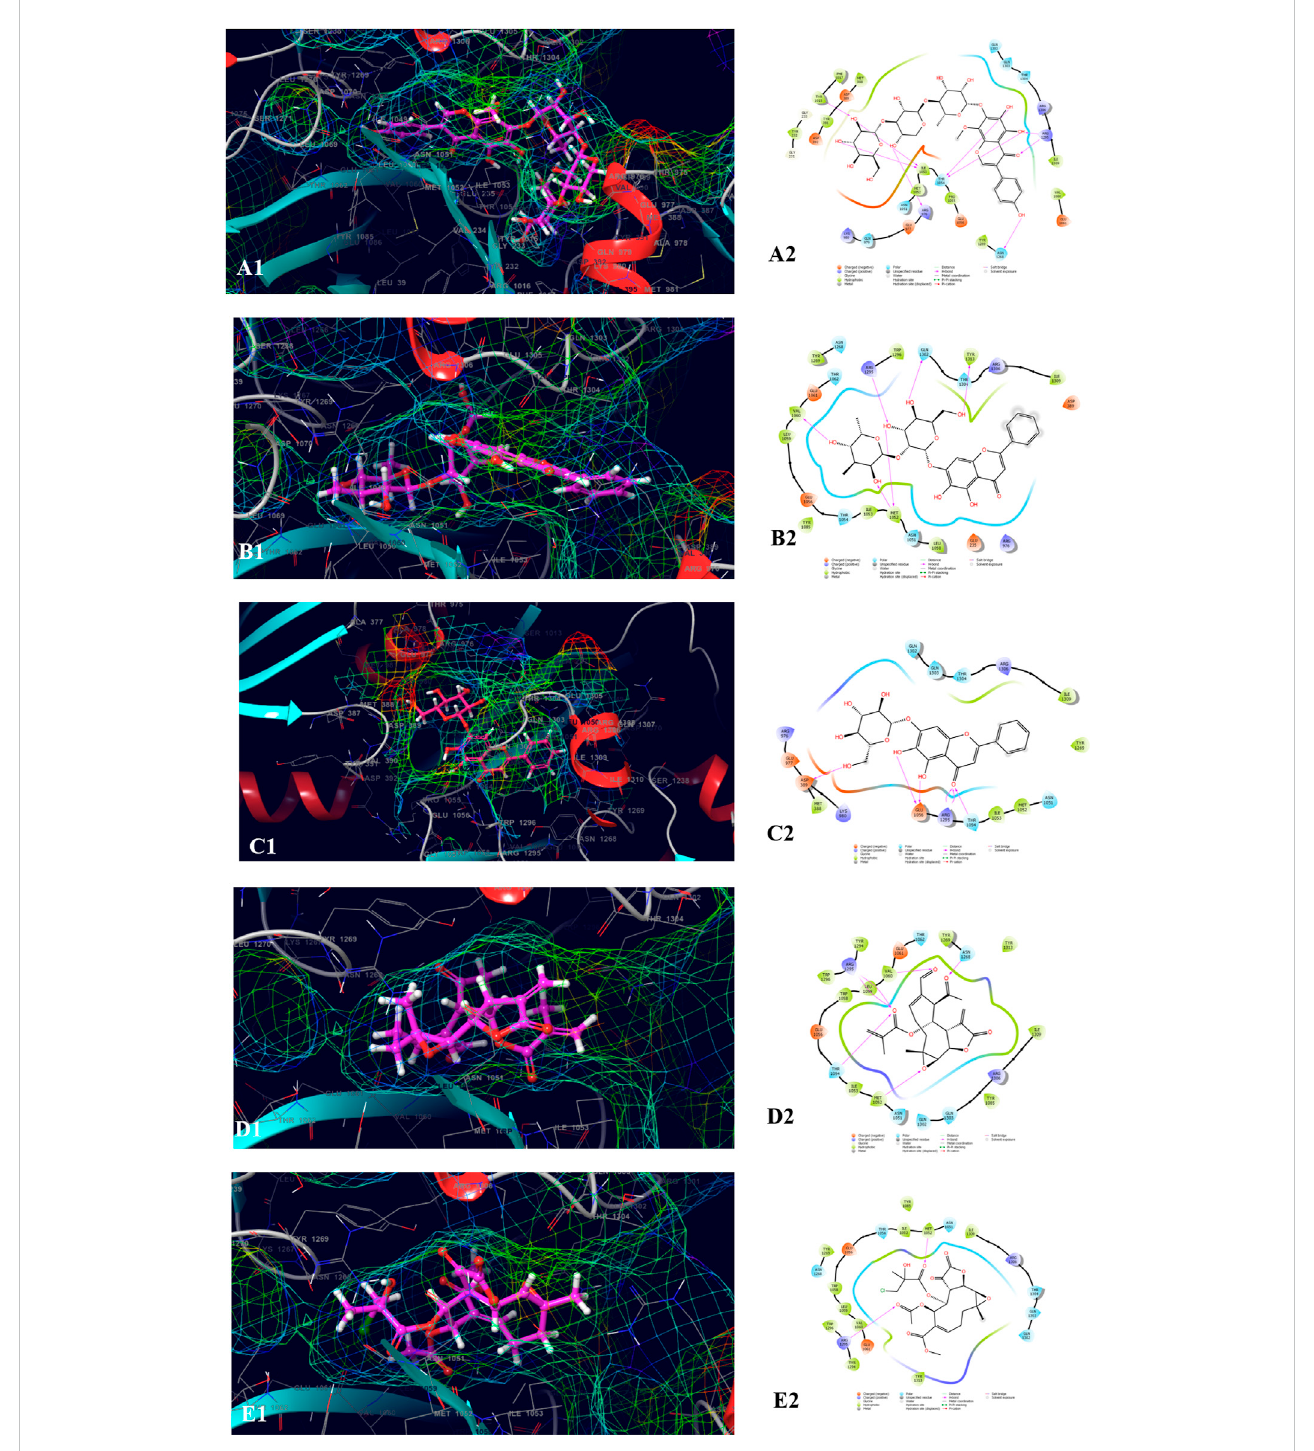
FIGURE 6 Molecular dockinginteractions ofmetabolitesinthebindingpocketofUDPglucose: glycoproteinglucosyltransferase2(Gene:UGGT2)(AlphaFold).[3D and 2D representation of 4 ′ ,5,6,7-Tetrahydroxy-8-methoxy iso fl avone-7-O-beta-D-galactopyranosyl-(1 → 3)-O-beta-D-xylopyranosyl-(1 → 4)- O-alpha-L- rhamnopyranoside (A1,A2) , Baicalein-7-O-diglucoside (B1,B2) , Baicalein-7-O-glucoside (C1,C2) , 8-beta-Methacryloyloxy-9alpha-acetoxy- 14oxoacanthospermolide (D1,D2) , and 8-Deepoxyangeloyl-8-2-hydroxy-3-chloro-isobutyroyl-enhydrin (E1,E2) inthebinding pocket ofUDP glucose: glycoprotein glucosyltransferase 2 (Gene: UGGT2)